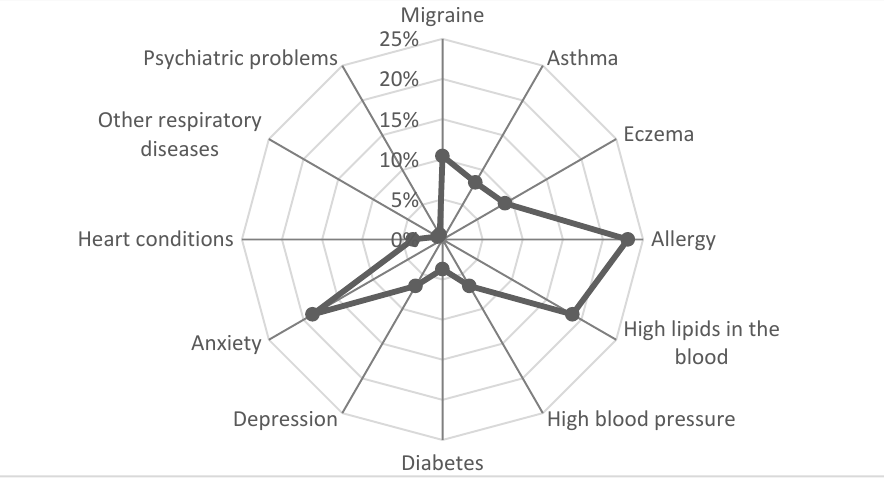
Figure 2. Occupants’ medical history.